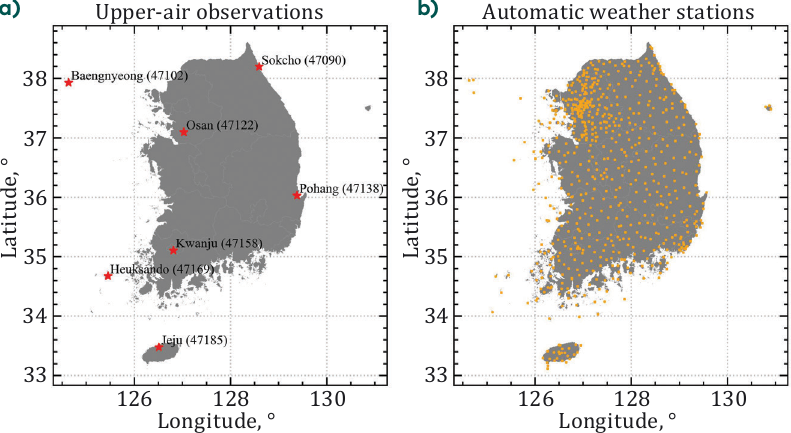
Figure 5. Distribution of upper-air observation and automatic weather station in South Korea